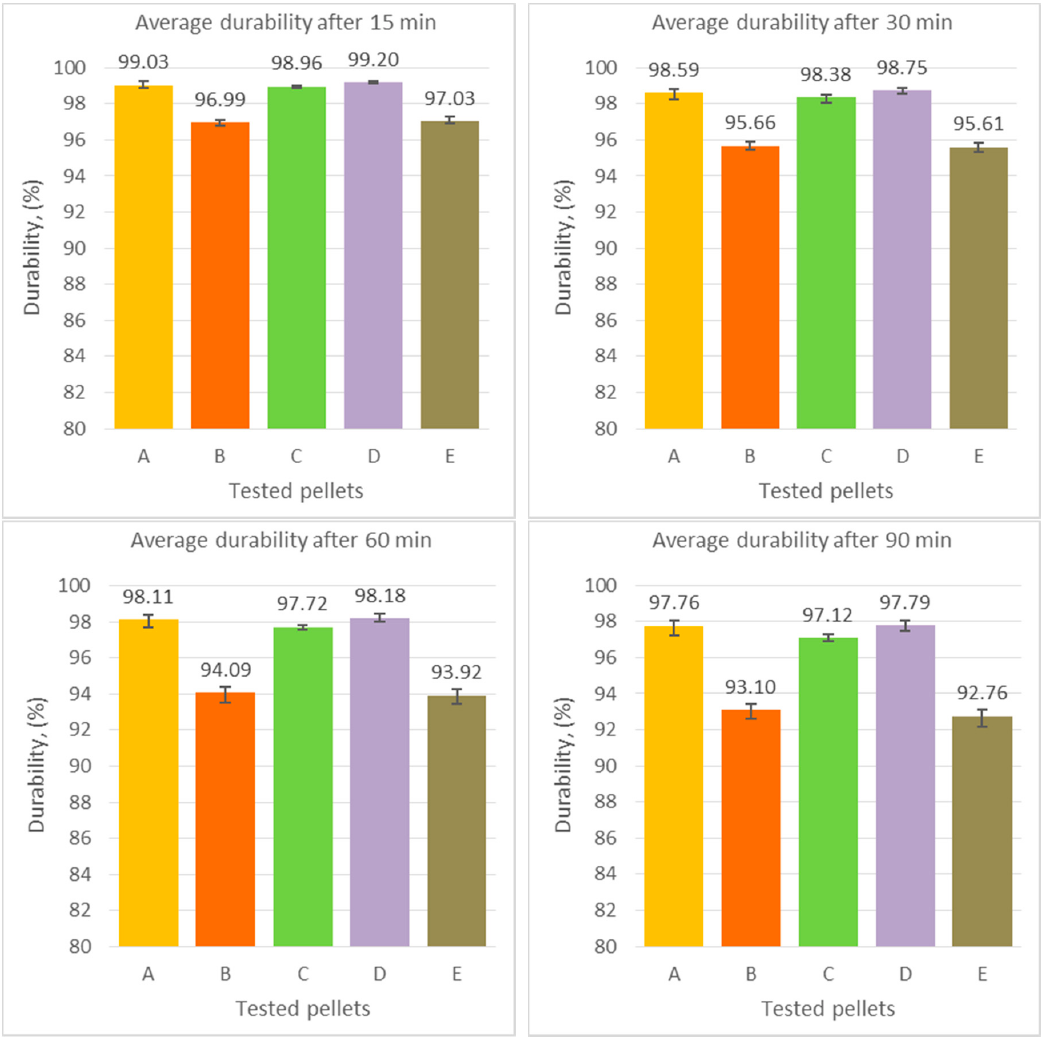
Figure 4. Results of durability of tested pellets in vertical vibration tests for different duration timing (own study).